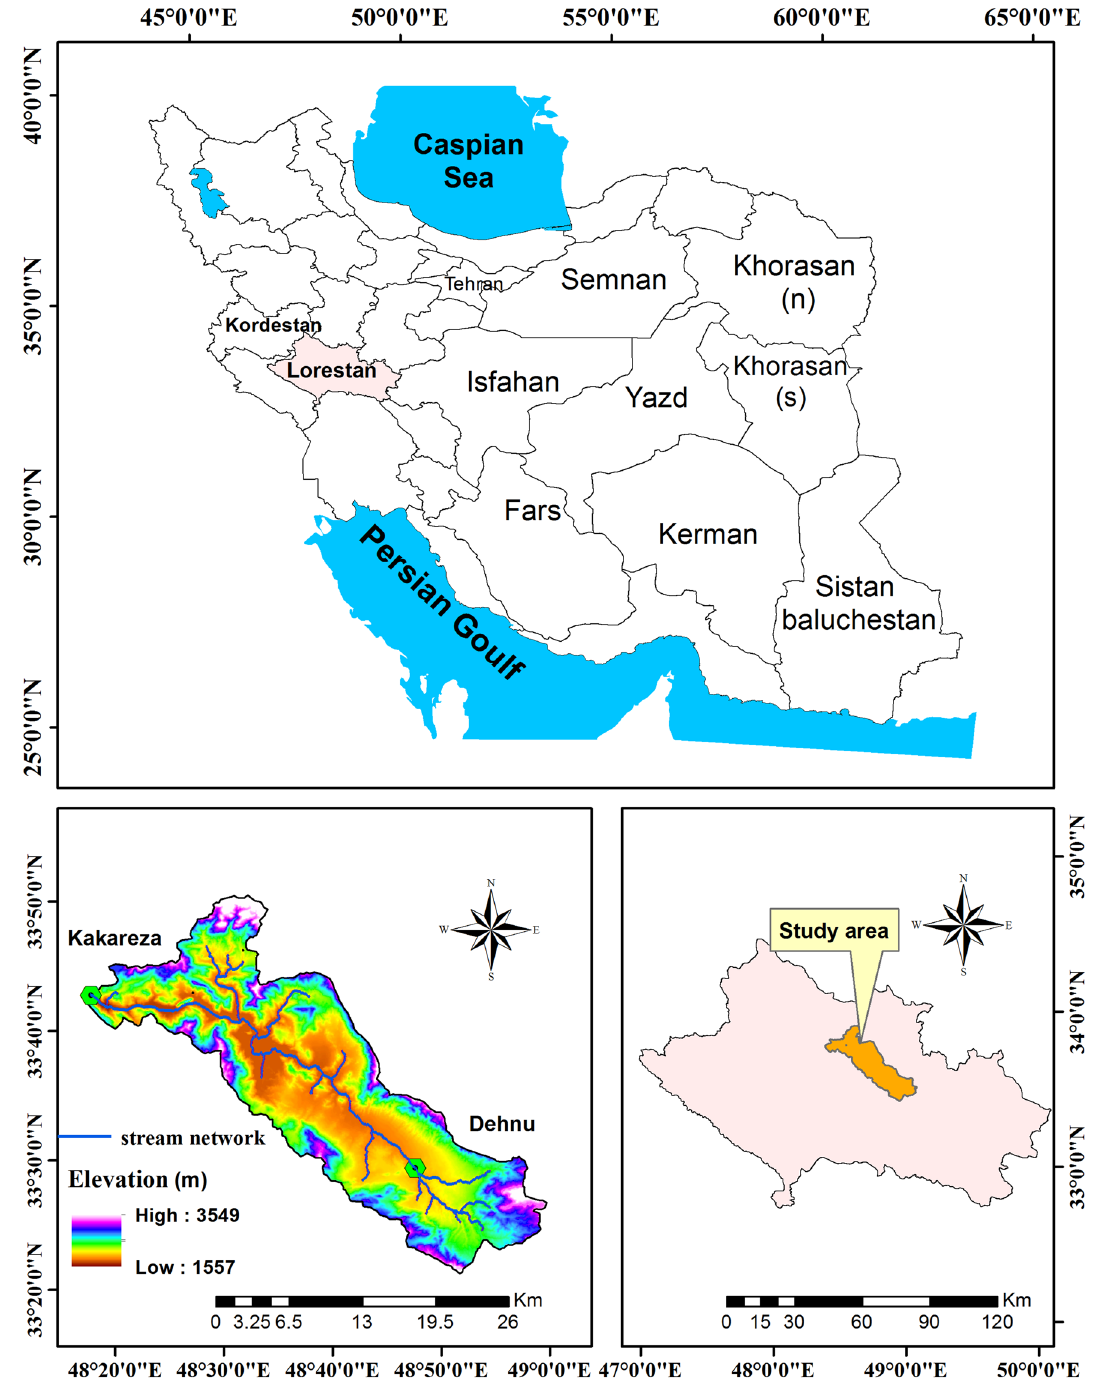
Fig. 1 Case study position in Lorestan,